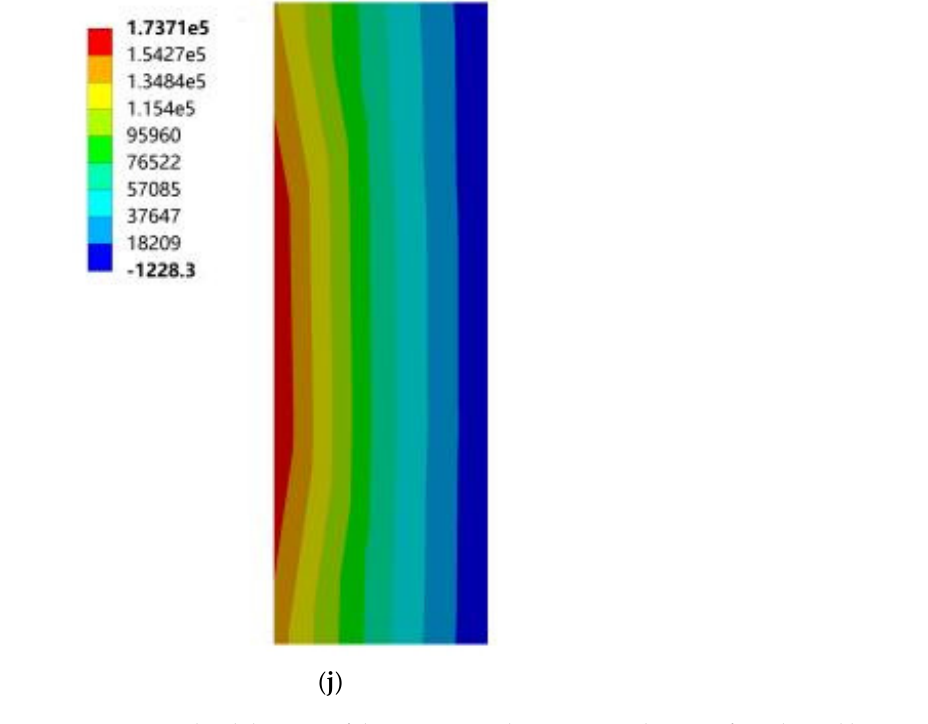
Figure 20. Cloud diagram of the maximum elastic principal strain of southward horizontal sun visors. ( a ) South to southeast wind. ( b ) South to northwest wind. ( c ) South by west 15 to southeast wind. ( d ) South by west 15 to northwest wind. ( e ) South by west 30 to southeast wind. ( f ) South by west 30 to northwest wind. ( g ) South by east 15 to southeast wind. ( h ) South by east 15 to northwest wind. ( i ) South by east 30 to southeast wind. ( j ) South by east 30 to northwest wind.